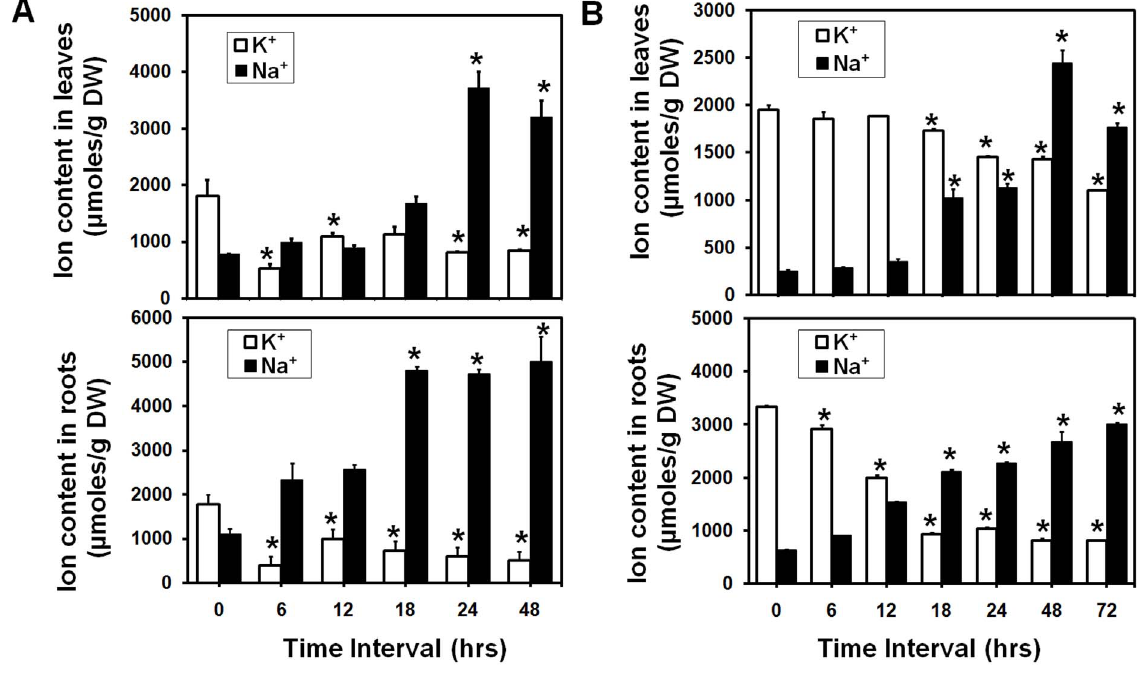
Figure 8. Total intracellular ion measurement in leaves and roots of early and mid stage mungbean seedlings. Na + and K + content in (A) leaves and (B) roots of unstressed and salt stressed mungbean seedlings harvested at time intervals of 0, 6, 12, 24, 48, and 72 hrs was measured using Flame Photometer. Values indicate means 6 SE (n=3). Statistically significant values at P # 0.05 are indicated as ‘‘*’’, using Bonferroni analysis.